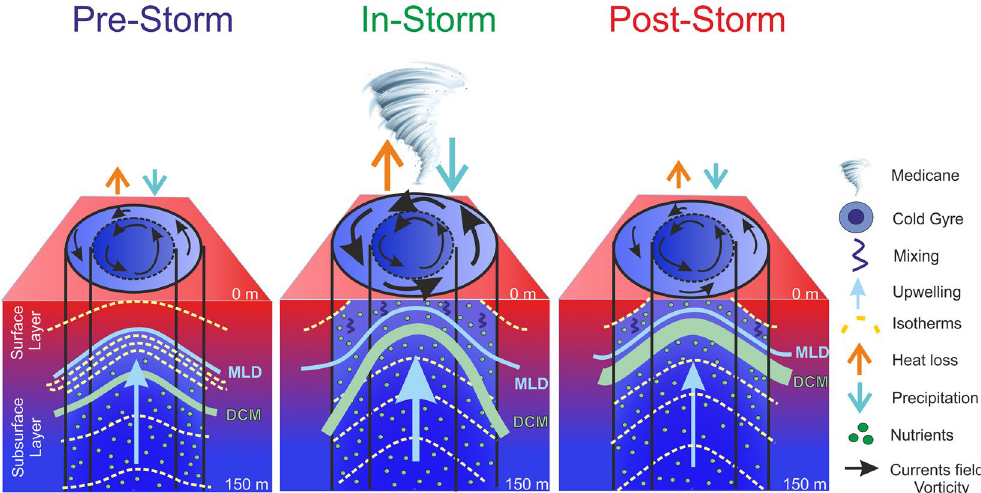
Figure 7. Schematic representation of the effects of Medicane Apollo on the Ionian Sea cyclonic gyre. The colors range from red to blue representing higher and lower temperatures,